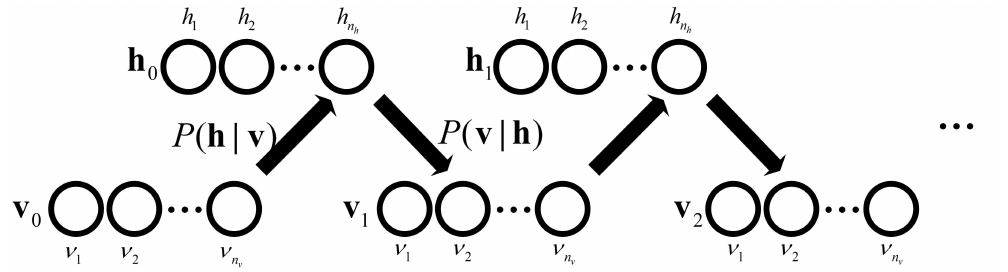
Figure 9. Approximate inference for visible and the first hidden layer in deep Boltzmann machine (DBM) training by Gibbs sampling.